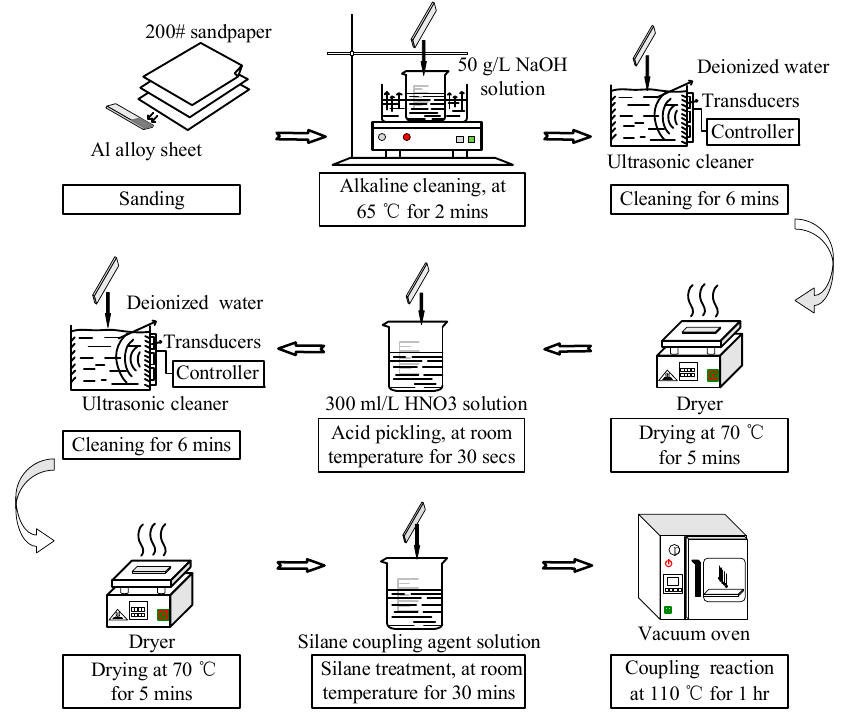
Figure 5. Pretreatment of the Al alloy specimens.